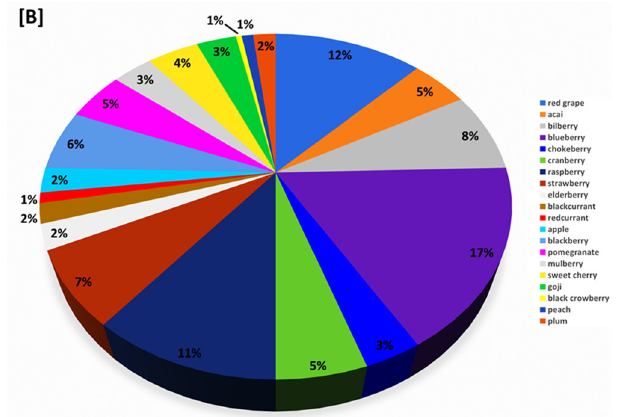
Figure 3. Published literature on anthocyanin analysis of fruits and berries between 2000 and 2022. ( A ) Contributions according to analytical methods. ( B ) Contributions according to the fruit/berries